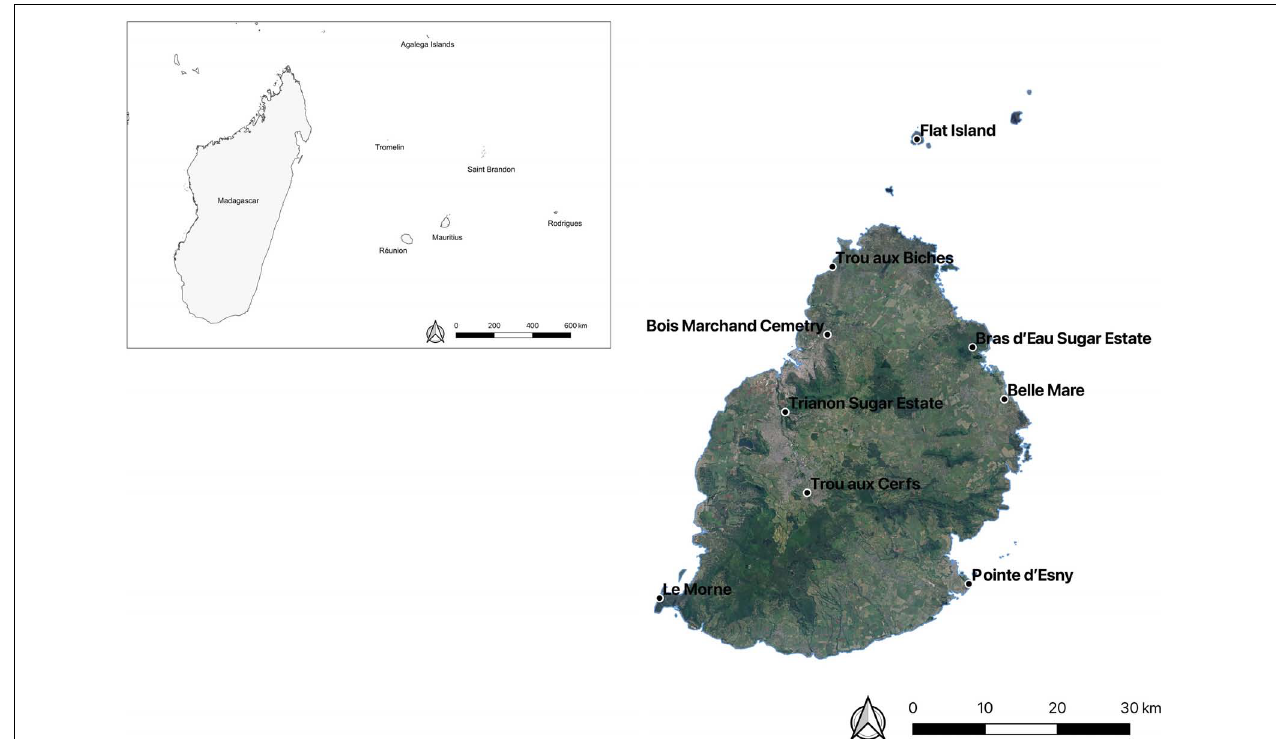
FIGURE 1 | Map of Mauritius with sites mentioned in text; inset situates the Mascarene Archipelago within the broader regional context.